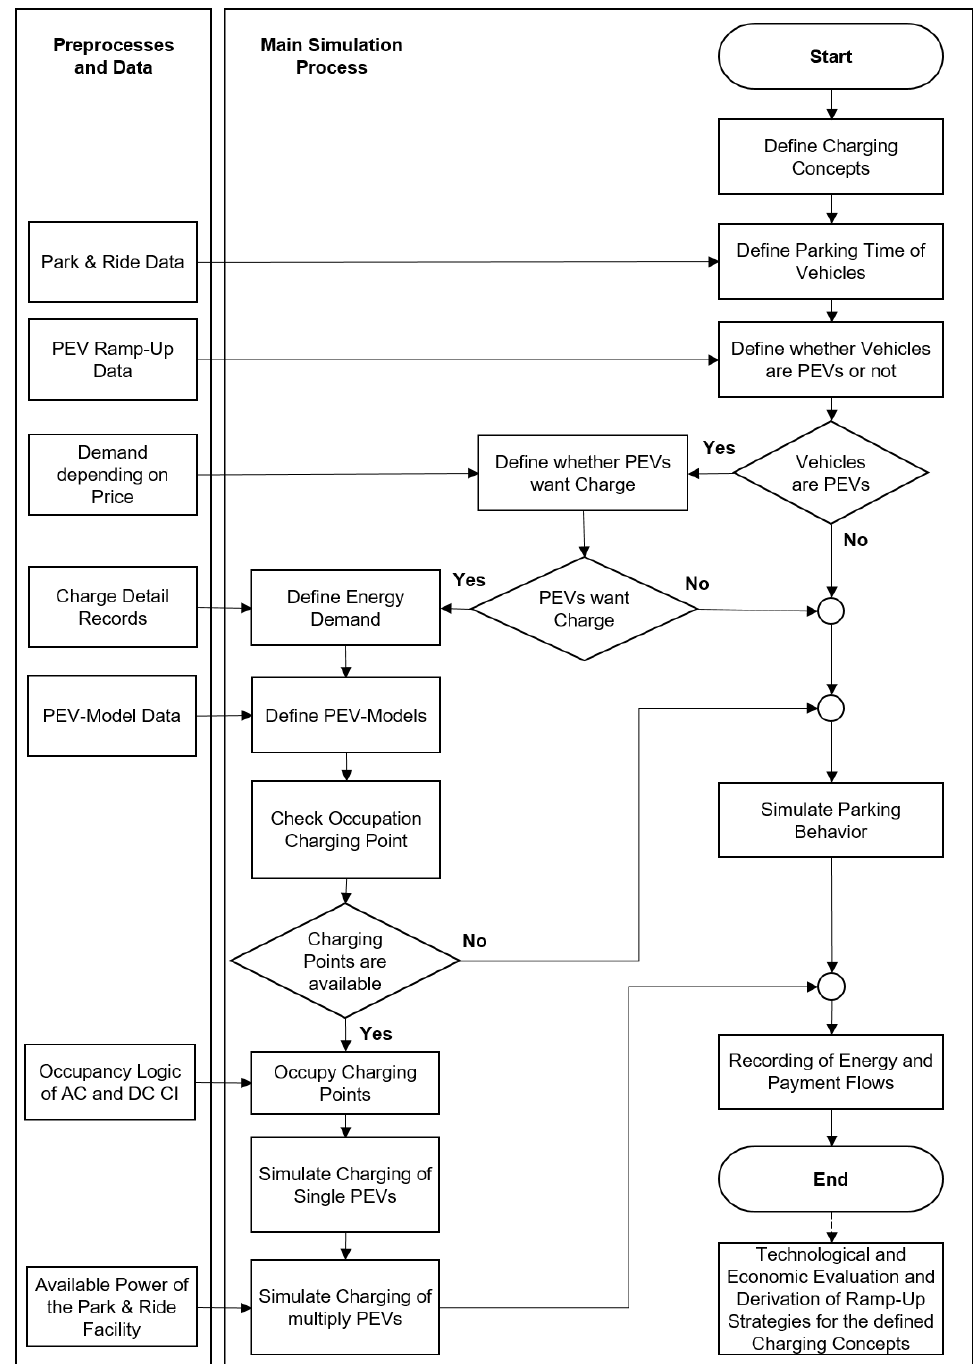
Figure 1. Flowchart of Agent-Based Model for the Evaluation of Charging Concepts using the Example of Park and Ride Facilities, further details explained in Section